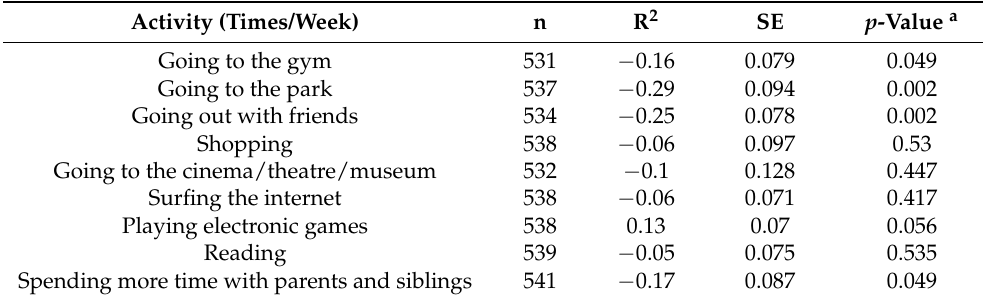
Table 4. Differences in crunning test performances by spare time-related aspects. All estimates were adjusted for gender and age.